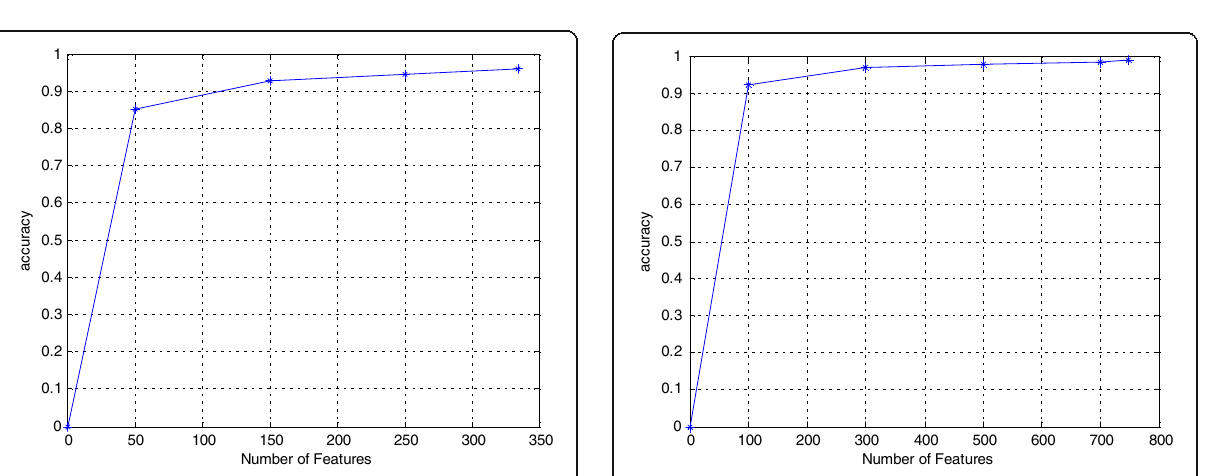
Fig. 7 Recognition rates with different number of multi-type